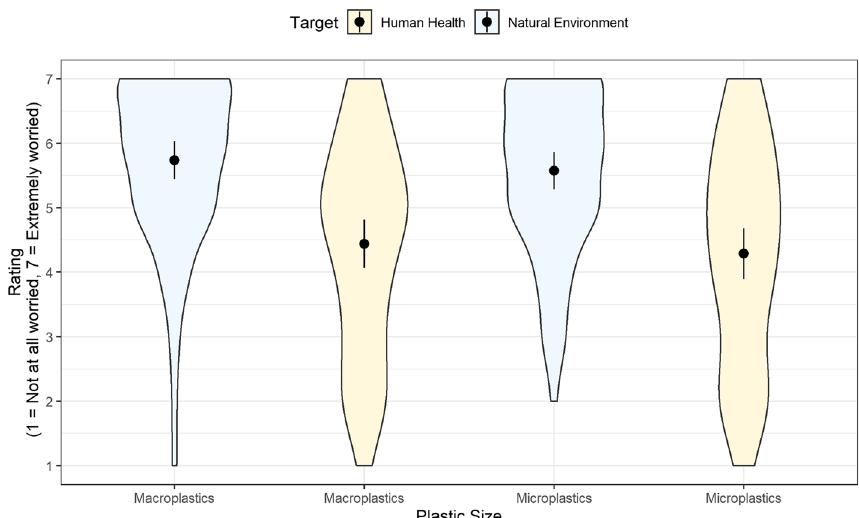
Fig. 1 Distribution and mean (with 95% CI) of the expert worry ratings about everyday products made out of plastics (macroplastics) and microplastics on the natural environment and human health